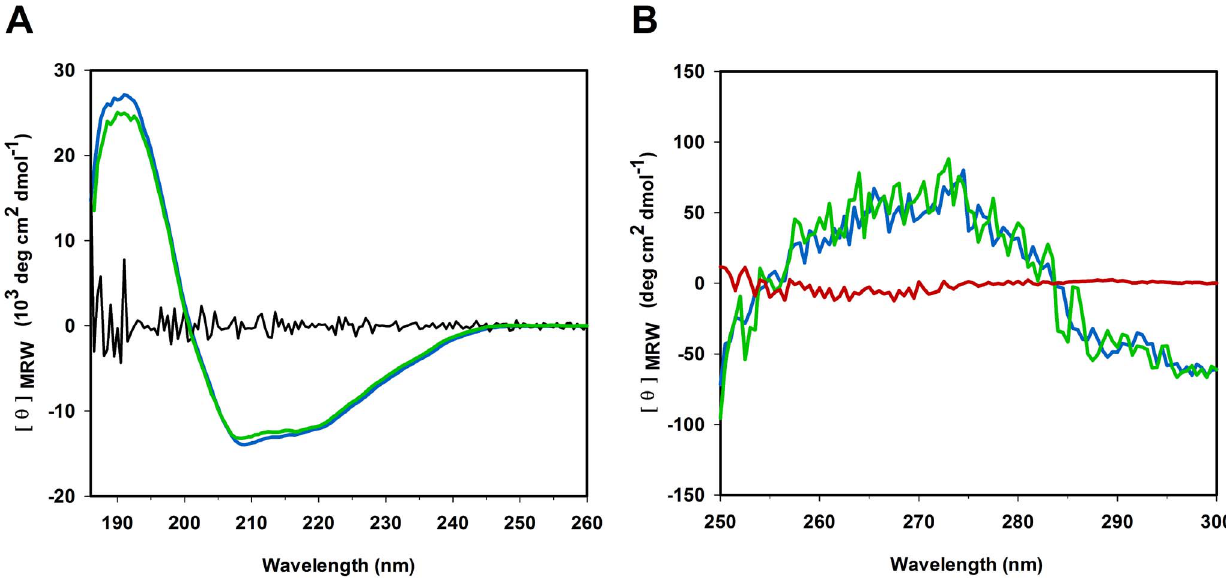
Figure 4. CD spectra of Ta AlDH. A) Far-UV CD spectrum of soluble Ta AlDH (blue) and refolded Ta AlDH (green) with standard deviation (black). B) Near-UV CD of soluble Ta AlDH (blue), refolded Ta AlDH (green) and unfolded Ta AlDH (red).